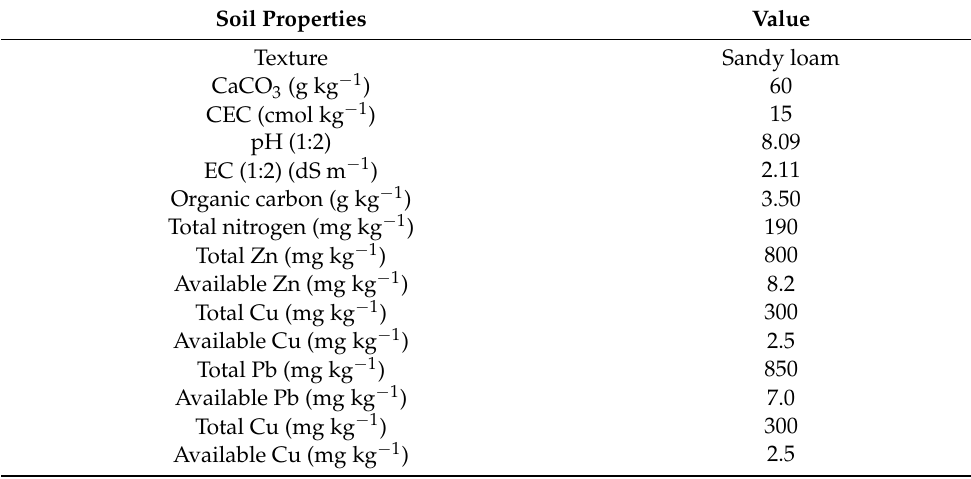
Table 1. Basic analysis of the studied soil. Soil